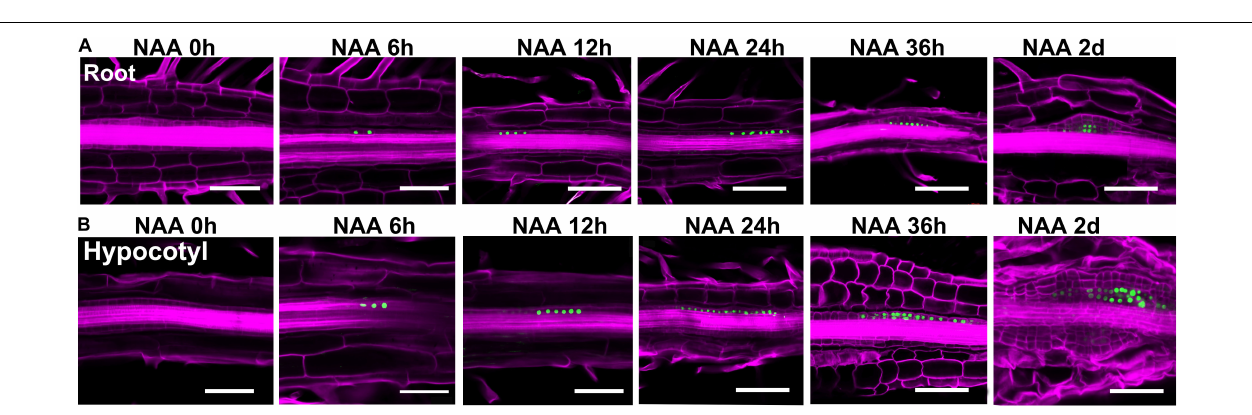
FIGURE 4 | Expression signals of the pWOX5:RFP; gWUS-3GFP double reporter lines during shoot regeneration. (A) Procedure of direct regeneration through conversion from LRP into shoot meristem. (B) Indirect regeneration from the hypocotyl-derived callus. Days after NAA-treatment or SIM-culture are indicated on top of each panel. Scale bars represent 50 µ m.